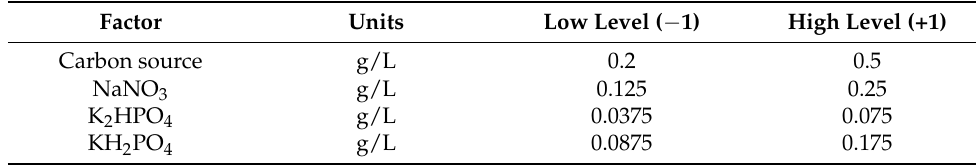
Table 1. Variables evaluated with their respective levels. Factor Units Low Level ( − 1) High Level (+1) Carbon source